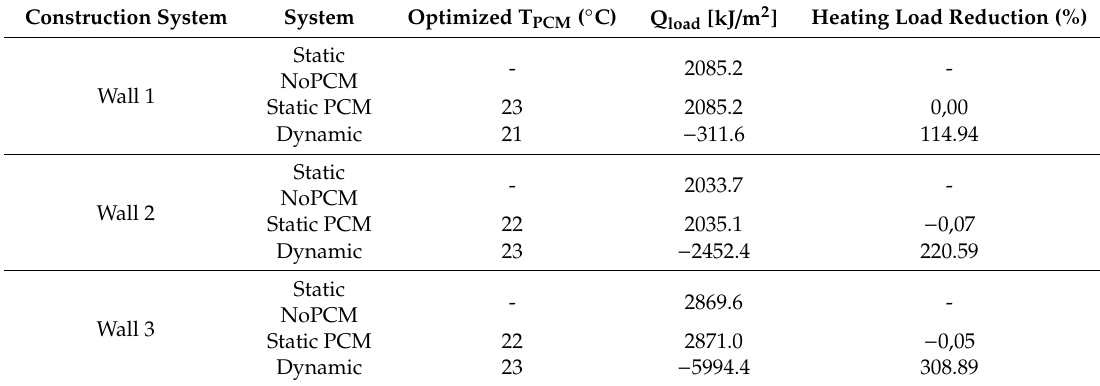
Table 2. Heating load reduction by using static and dynamic PCM for each constructive system.